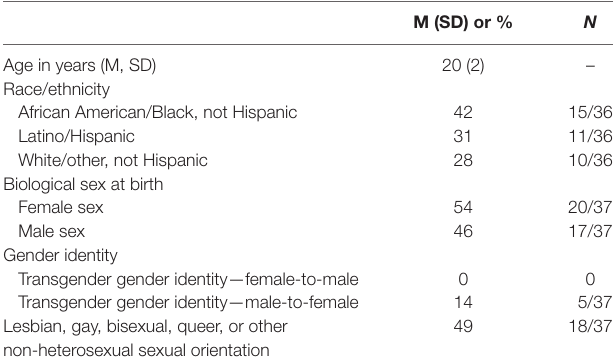
Table 2 | Runaway and homeless youth client sociodemographic and background factors [Mean (SD) or %], N =